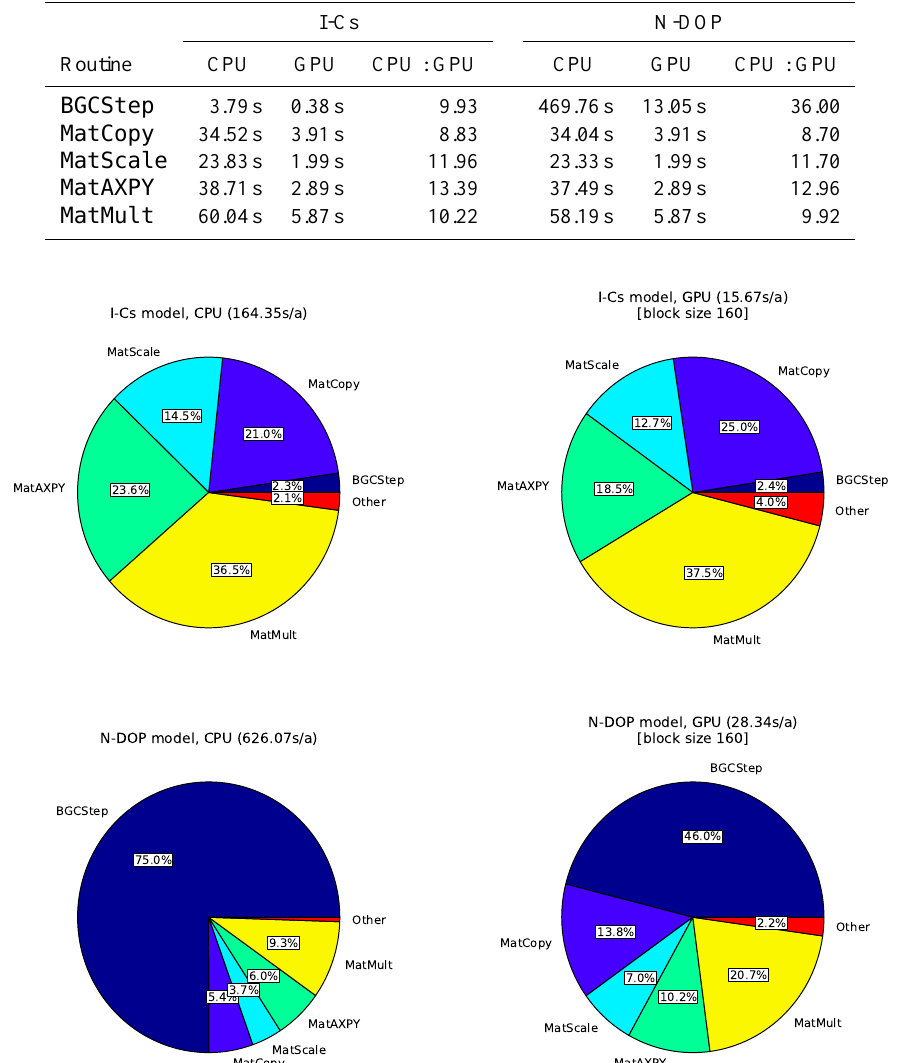
Table 5. Mean computational time within one model year and performance gains of the individual routines depicted in Table 4.